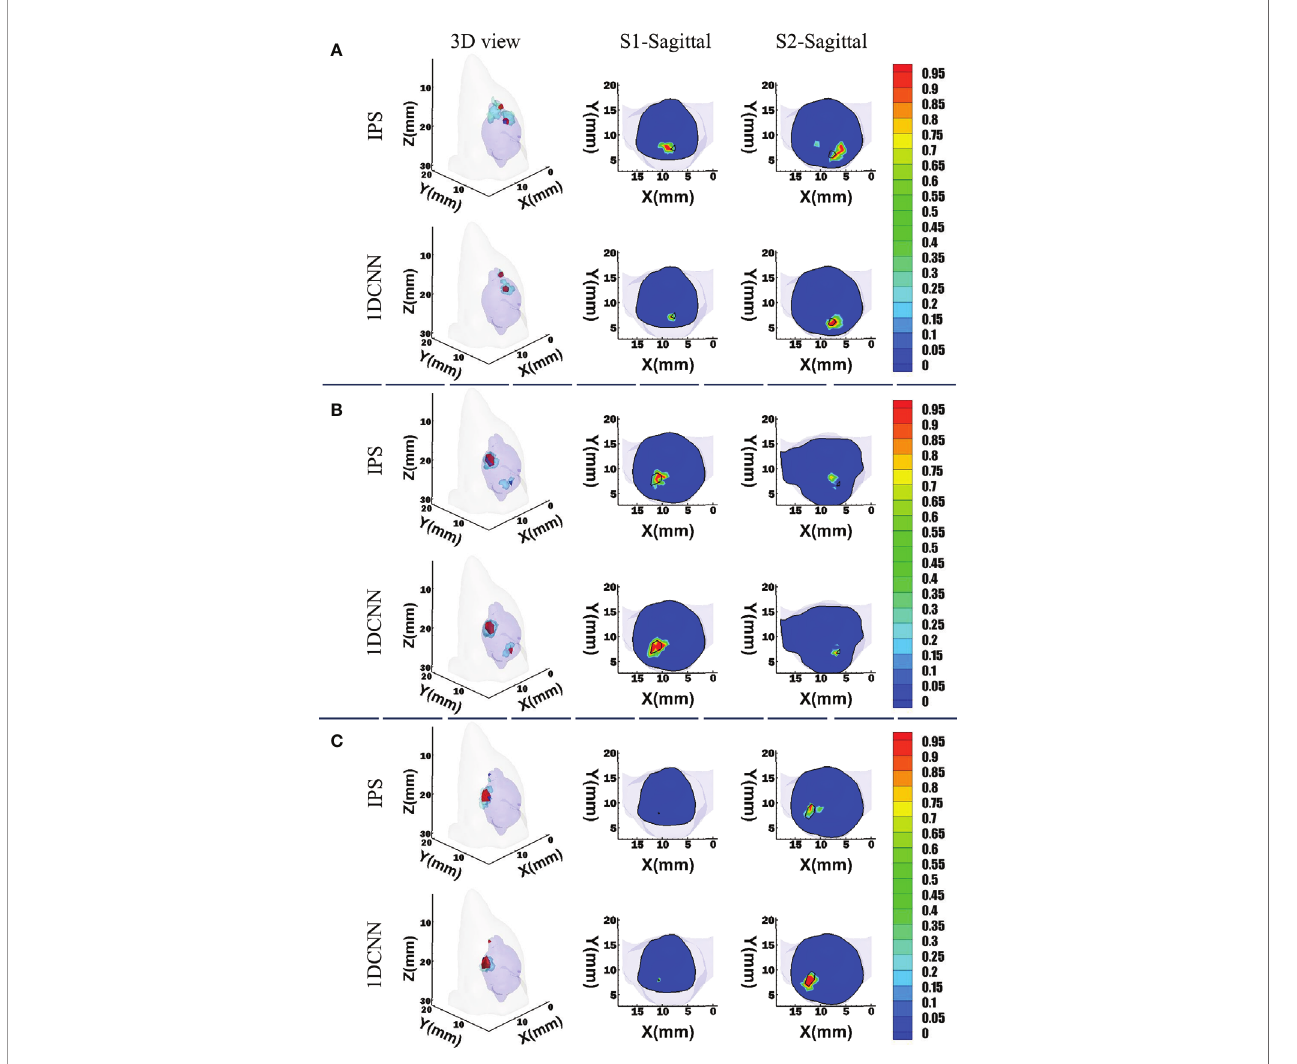
FIGURE 5 | 3D views and the corresponding transverse views of reconstruction results by the 1DCNN and the IPS in the dual-source cases. (A) Case 1; (B) case 2; (C) case